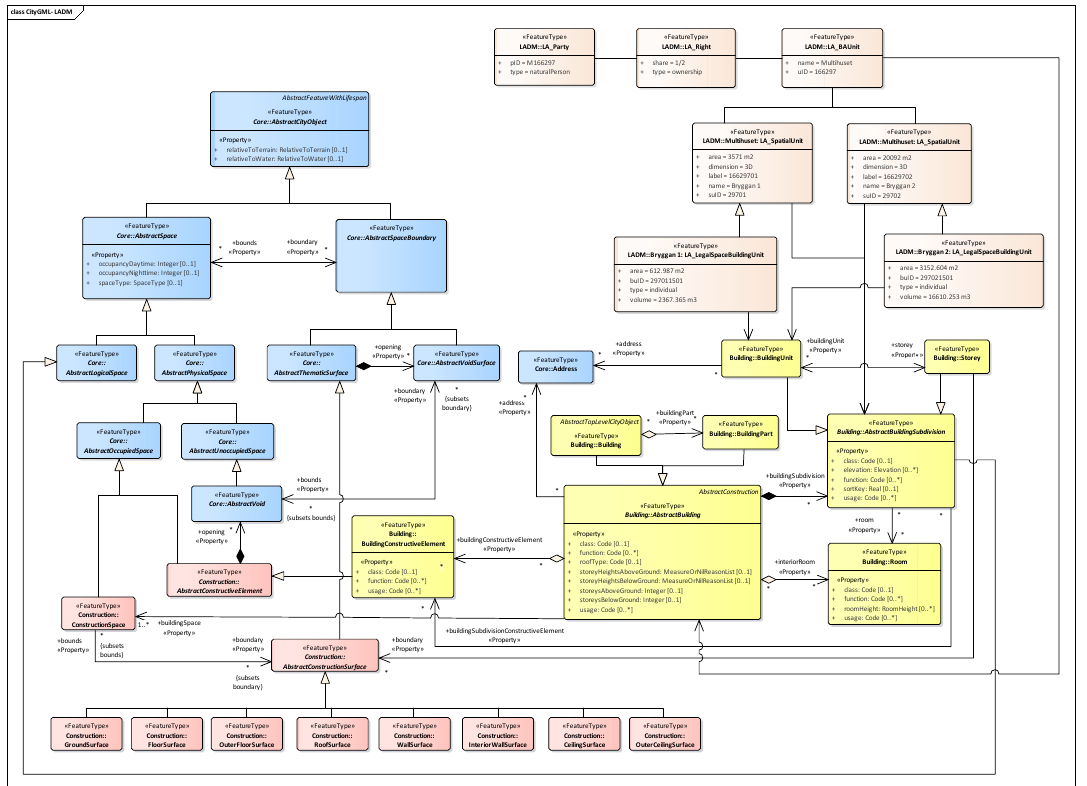
Figure 17. The Unified Modeling Language (UML) diagram for integration of CityGML 3.0 with LADM.